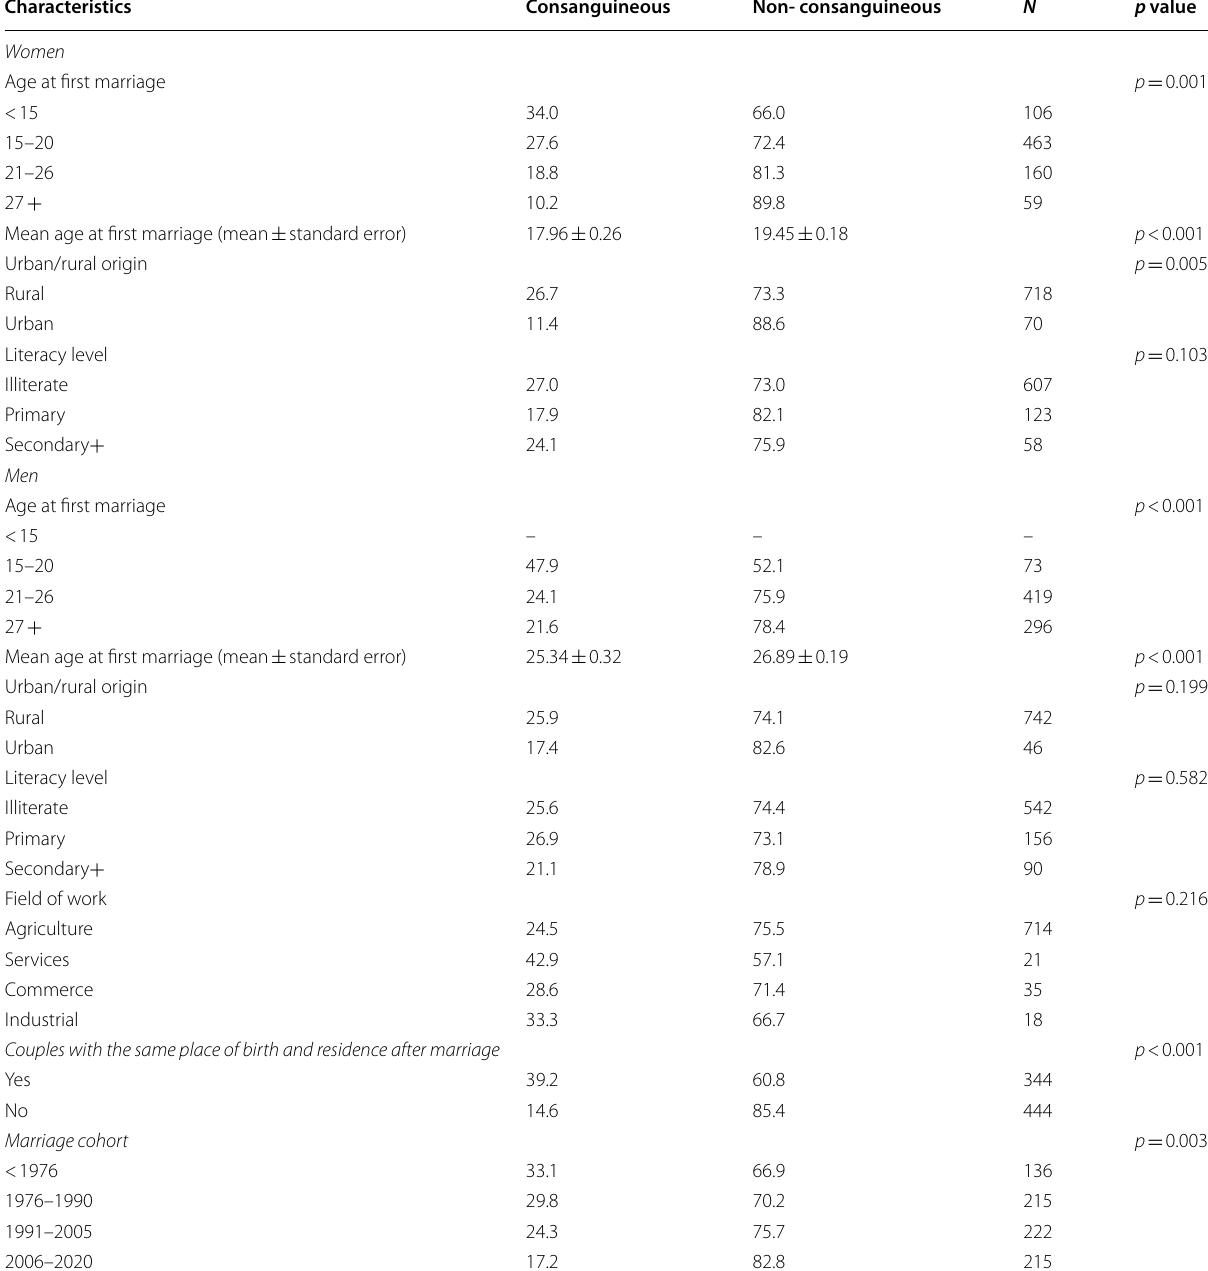
Table 3 The relationship between consanguinity and socioeconomic and demographic characteristics in both genders